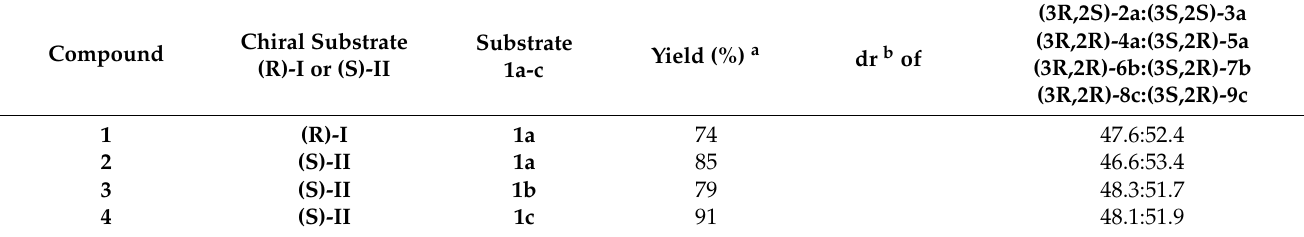
Table 1. N-alkylation of 3-(piperidin-3-yl)-1H-indole derivatives 1a-c using (R)-2-(4-toluene- sulfonyloxy)-phenylacetic acid methylester (R)-I and (S)-2-(4-toluenesulfonyloxy)-phenylacetic